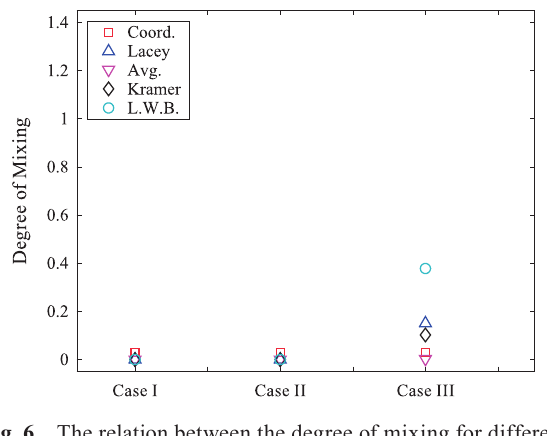
Fig. 7 The degree of mixing with the Lacey mixing index with different sizes of cells for series B. The cell num- ber N = 216 for n = 8, N = 64 for n = 27, N = 27 for n = 64, and N = 8 for n = 216. Symbol fill: black, exact